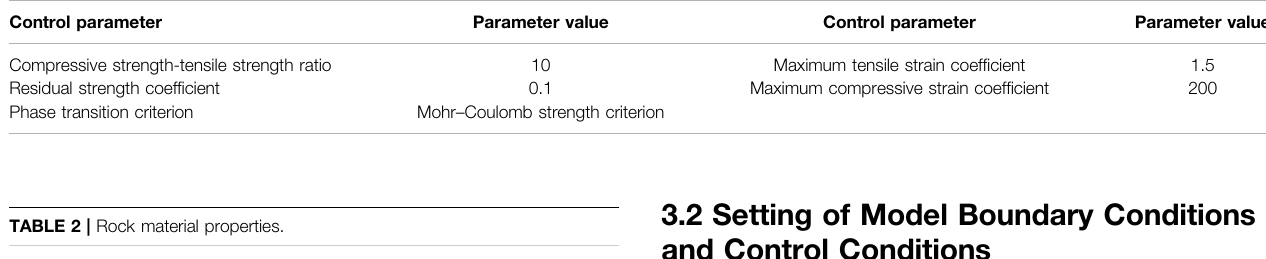
TABLE 1 | Phase change criterion control parameters.